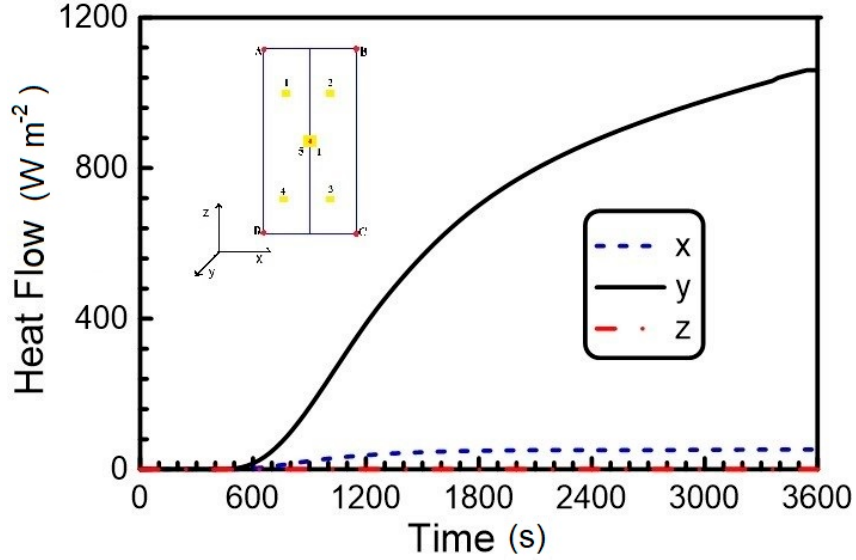
Figure 8. Measurement point 1: decomposition of the heat flow as a function of time along the Cartesian directions (x, y, z).